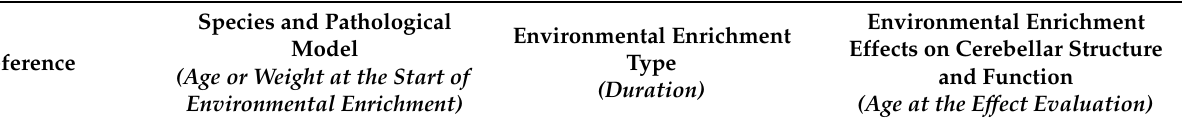
Table 2. Studies on neuroprotective environmental enrichment effects in pathological animal